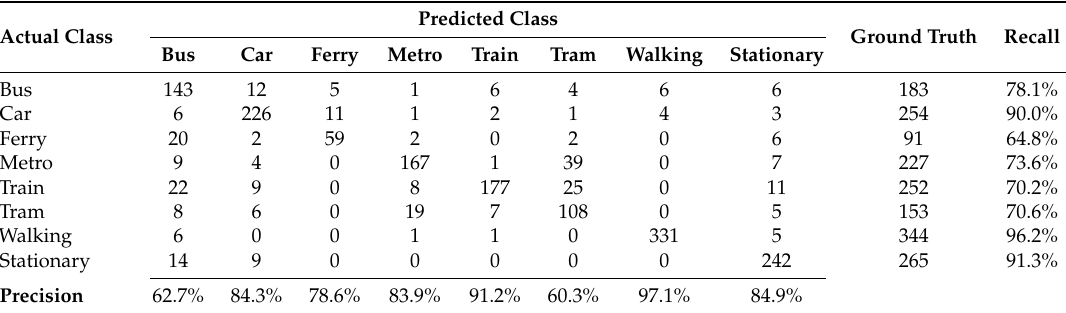
Table 6. Confusion matrix without applying the Healing algorithm.